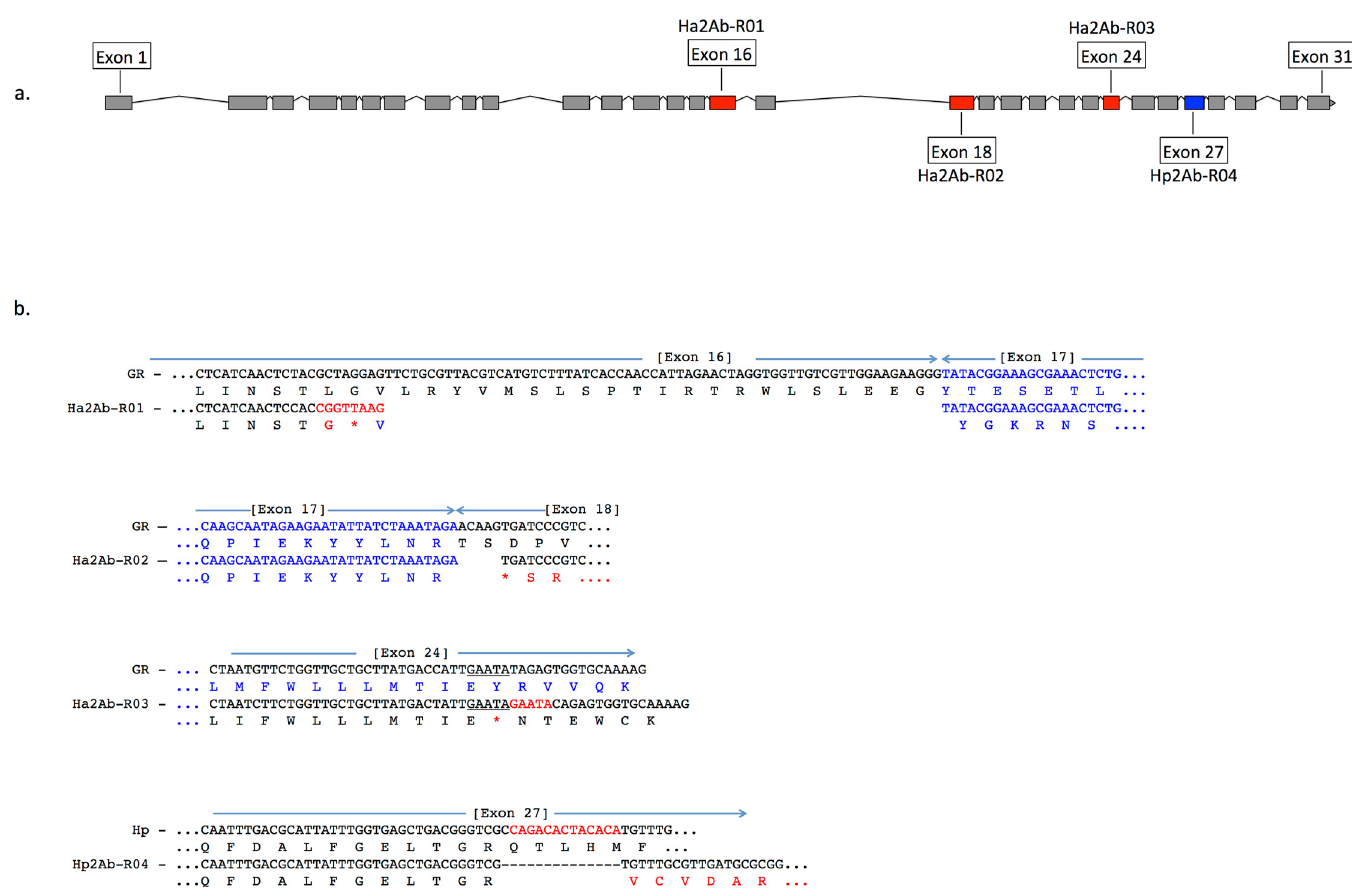
Fig 4. A summary of the three Cry2Ab resistance alleles (Ha2Ab-R01, R02, R03) in the ABCA2 gene in Helicoverpa armigera , and one H . punctigera Cry2Ab resistance allele (Hp2Ab-R04). The ABCA2 gene consists of 31 exons (Fig 4a), with mutations at exons 16, 18, 24 and 27 indicated by red (for H . armigera ) and blue (for H . punctigera ) boxes. Fig 4b: The Ha2Ab-R01 allele was the result of a 73 base pair (bp) deletion at the c-terminus of exon 16, and the insertion of a 8bp ‘ CGGTTAAG ’ sequence, and resulted in a glycine (G) replacing the leucine (L) amino acid followed by a premature stop codon ( * ) (in red). The Ha2Ab-R02 allele was the result of a 5bp ‘ ACAAG ’ deletion at the start of exon 18 that resulted in a premature stop codon. The Ha2Ab-R03 allele was the result of a 5bp ‘ GAATA ’ target site duplication signature reminiscent of past insertions by transposable elements. This duplication mutation also resulted in a premature stop codon in exon 24. The H . punctigera Hp2Ab-R04 allele was the result of a 14bp deletion, and resulted in missense mutations.